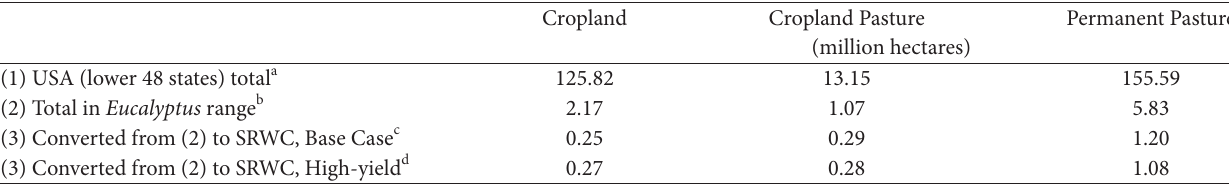
T 1: Area of cropland, cropland pasture, and permanent pasture (1) in the USA lower forty-eight states, (2) in Eucalyptus ranges in the Southeast, (3) potentially converted to Eucalyptus in a Base Case Scenario, and (4) potentially converted to Eucalyptus in a High-yield